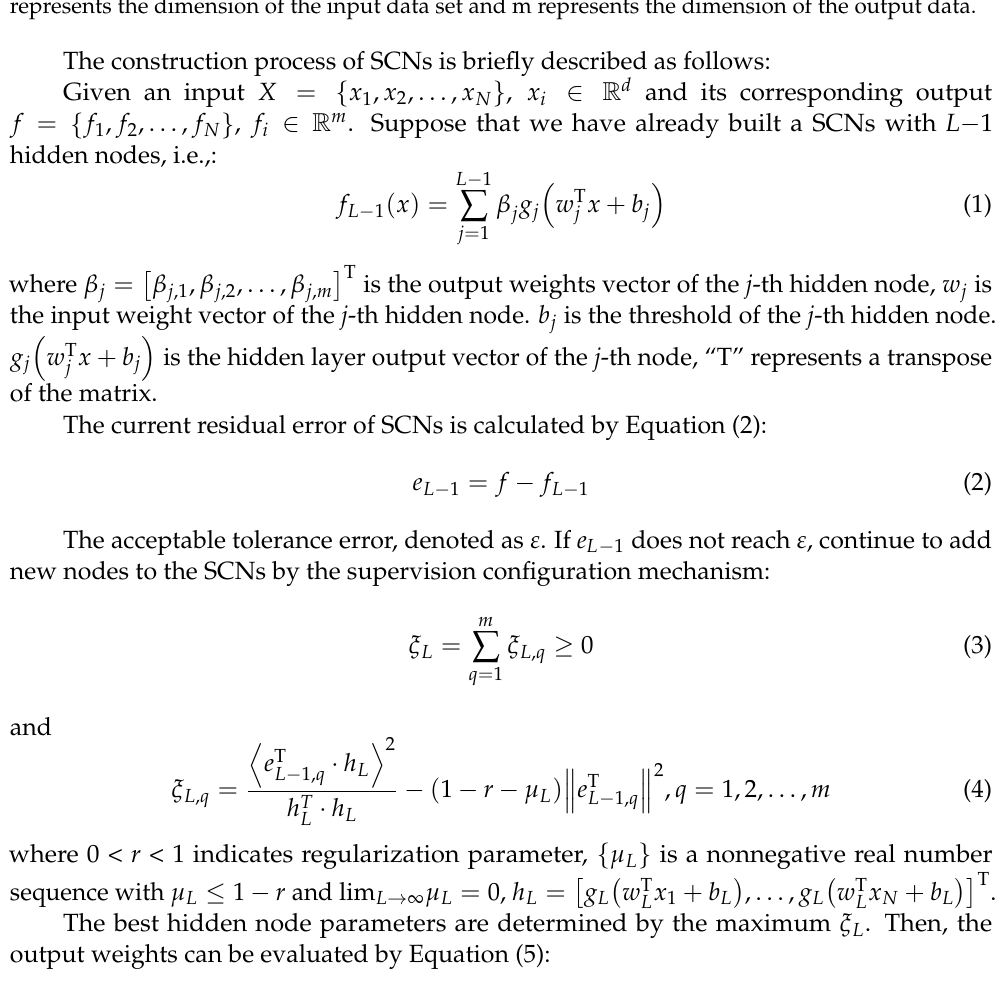
Figure 1. Network structure of SCNs. 1, 2, j , j + 1 represent the node 1, 2, j , j + 1 respectively. d represents the dimension of the input data set and m represents the dimension of the output